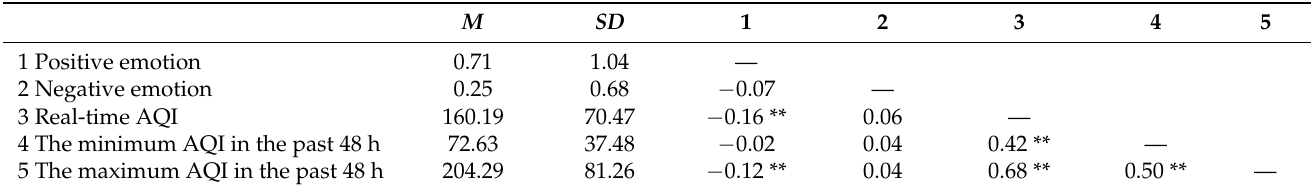
Table 2. Descriptive data and correlations between Weibo emotions and air quality